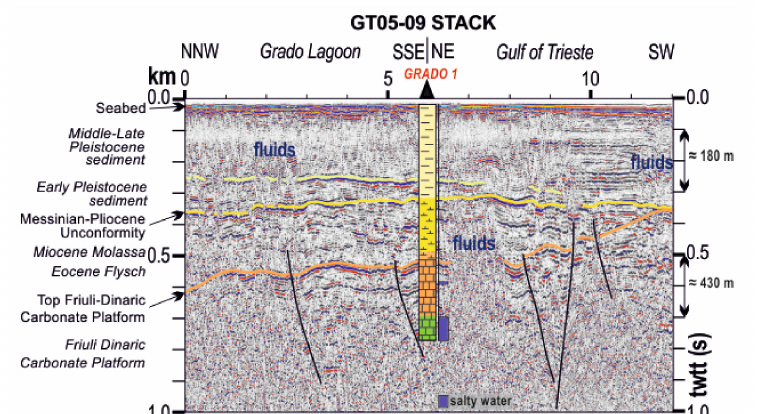
Figure 5. High penetration multichannel seismic profile GT05-09, offshore the Grado Island. The seismic shows the sedimentary sequence composed by the Meso-Cenozoic Friuli-Dinaric Carbon- ate Platform, buried under the Eocene flysch and Miocene Molassa, depicted by the Messinian- Pliocene Unconformity. Pleistocene sediments seal the entire sequence. The stratigraphy of the Grado 1 geothermal well [64,76], 0.5 km SE of the profile, is represented on the seismic profile. Depths are con- verted into twt by using mean P-wave velocity values obtained from tomographic analysis; [72–75]: 1750 m/s for the Pleistocene sediments (light yellow block), 2800 m/s for the terrigenous deposits of Molassa and Flysch (golden yellow and orange blocks, respectively), 4300 m/s for Lower Eocene- Paleocene and Cretaceous carbonates (orange and green blocks) containing two deep aquifers with salty waters. The seismic image shows the presence of fluids within the sedimentary